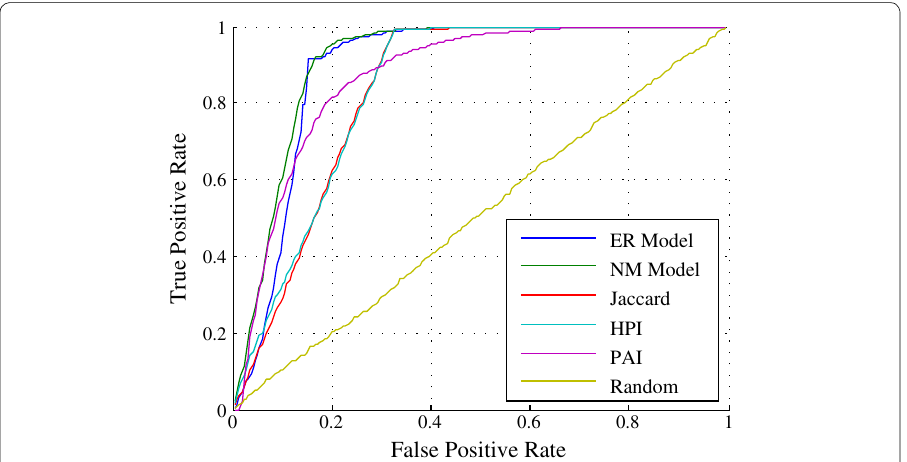
Fig. 3 ROC curve of different algorithms on the Brightkite graph data. The curves of the proposed methods are clearly above other competing